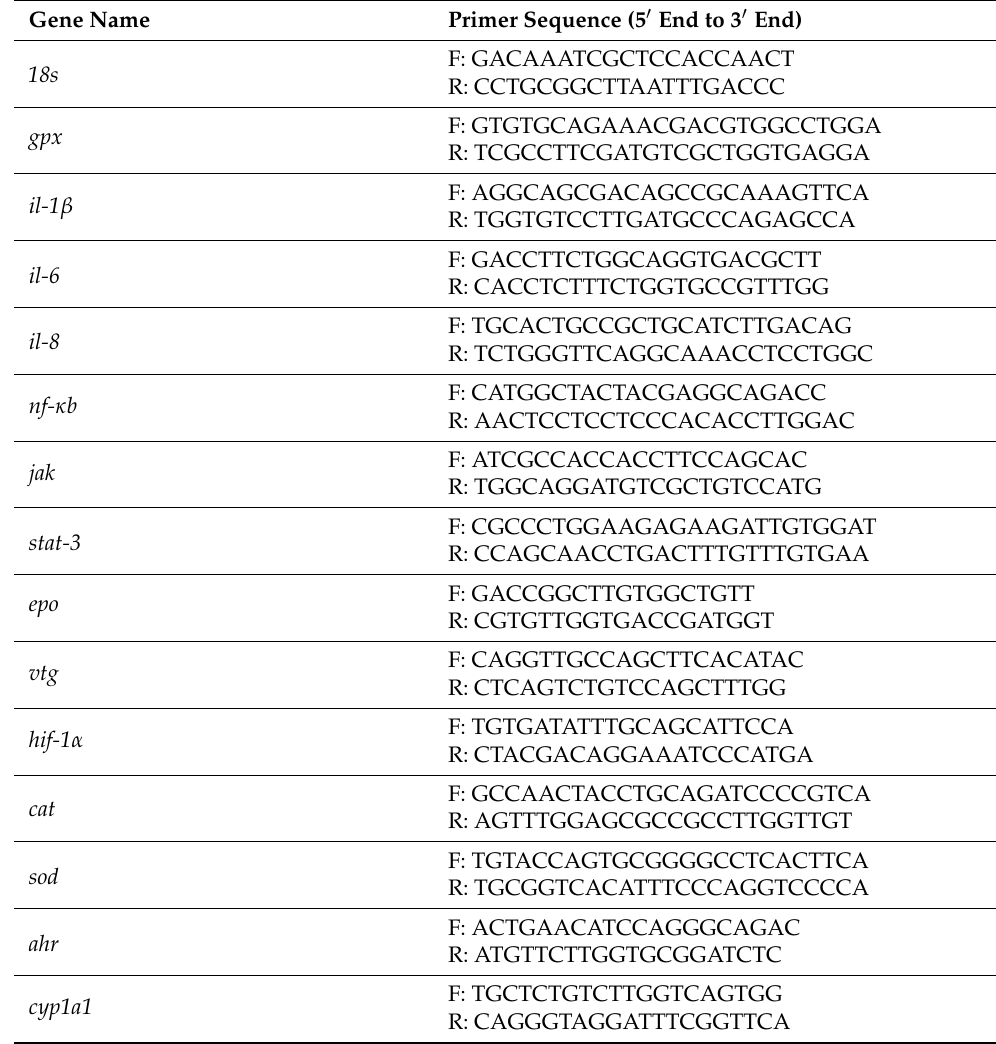
Table A1. Primer sequences used for qPCR in this study.